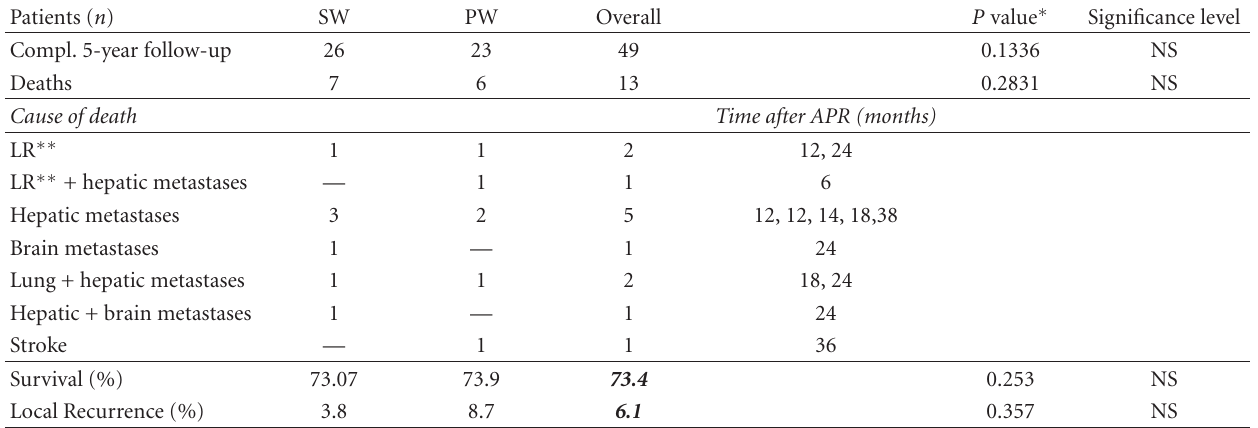
Table 5: Local recurrence and